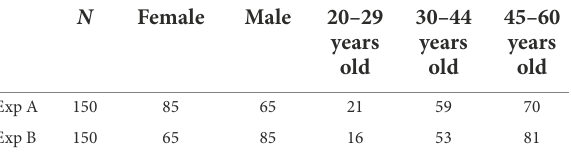
TABLE 2 The distribution of participants by age and